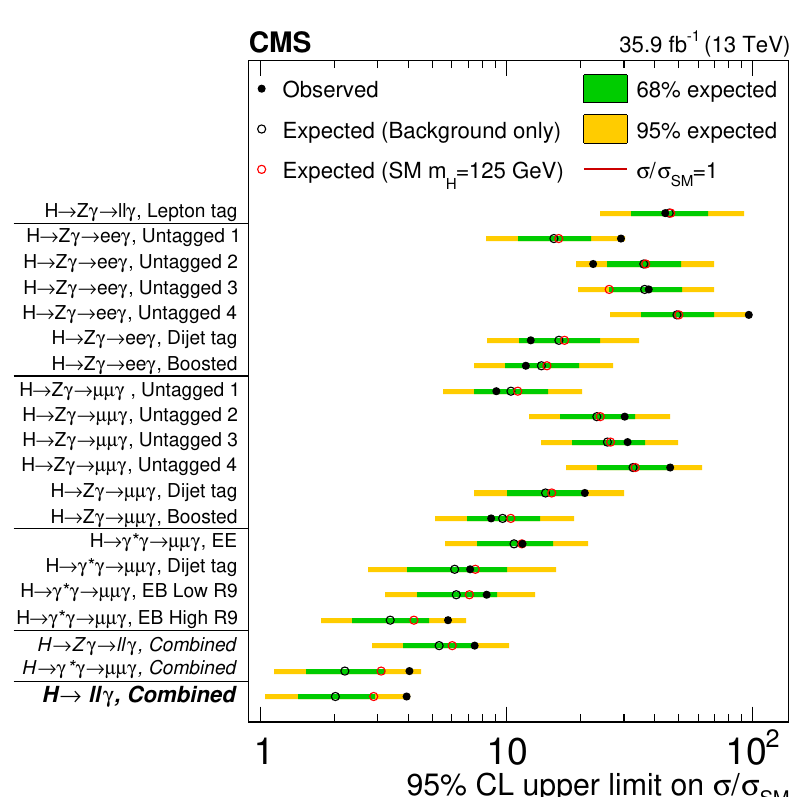
Figure 7 . Exclusion limit, at 95% CL, on the cross section of H for an SM Higgs boson of m H = 125 GeV. The upper limits of each analysis category, as well as their combinations, are shown. Black full (empty) circles show the observed (background only expected) limit. Red circles show the expected upper limit assuming an SM Higgs boson decaying to ‘‘(cid:13) decay